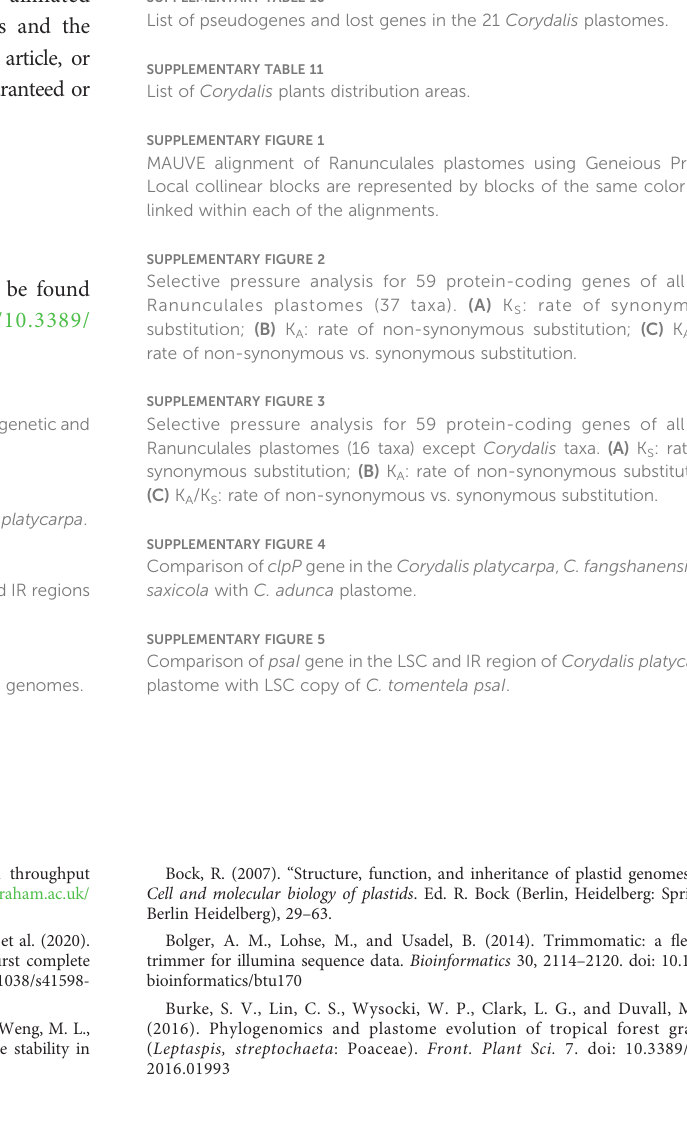
SUPPLEMENTARY TABLE 5 Presence of RNA editing sites, codon position, and amino acid conversion in the protein-coding genes of the 21 Corydalis plastomes. SUPPLEMENTARY TABLE 6 Amount of synonymous and non-synonymous substitution rates present in the 59 protein-coding genes of the 21 Corydalis plastomes. SUPPLEMENTARY TABLE 7 Amount of synonymous and non-synonymous substitution rates present in the 59 protein-coding genes of all the Ranunculales plastomes (37 plastomes). SUPPLEMENTARY TABLE 8 Amount of synonymous and non-synonymous substitution rates present